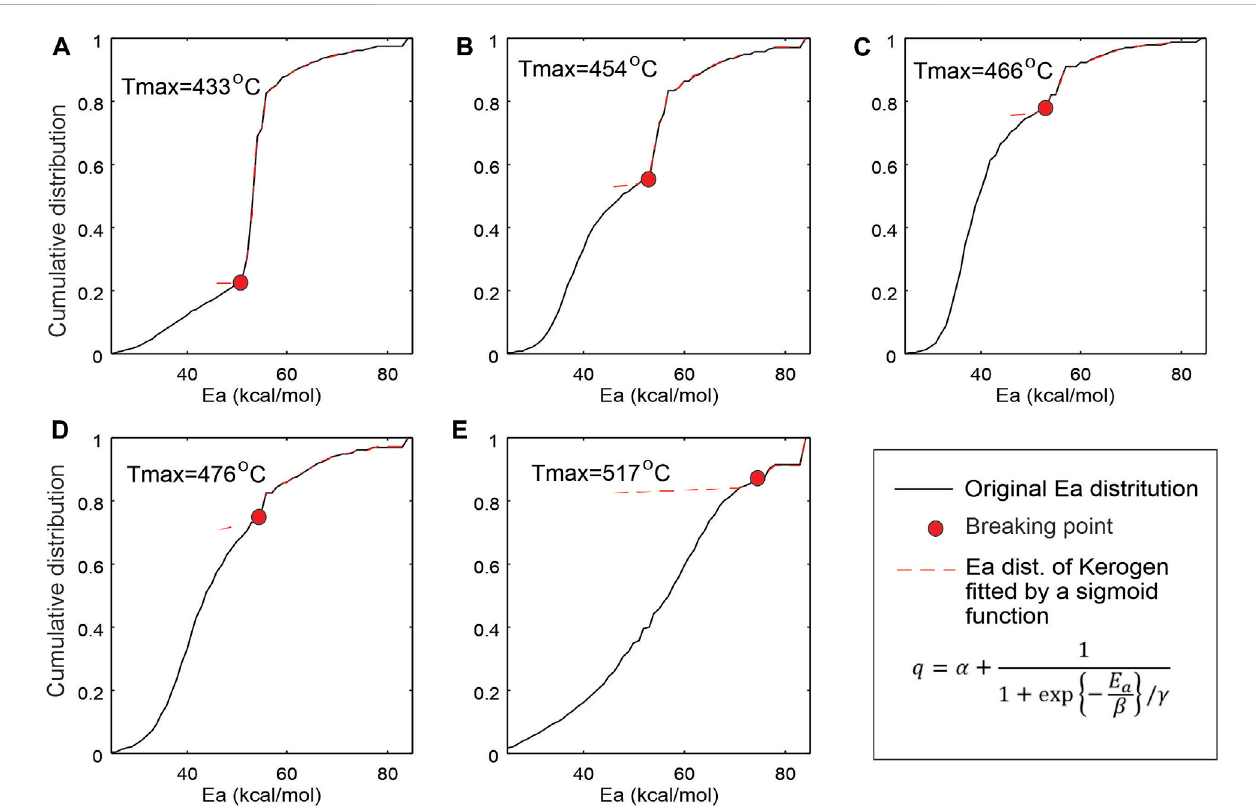
FIGURE 9 Separation of kerogen components from petroleum components in Ea domain. (A – E) correspond to samples C-590392, C-594351, C-590327, C- 590436 and C-590378 in Table 1. Each group was fi tted to a normal distribution, and separation in the mixed transitional area was achieved using a sigmoid function, in which α , β and γ are unknown parameters and obtained by fi tting the S2